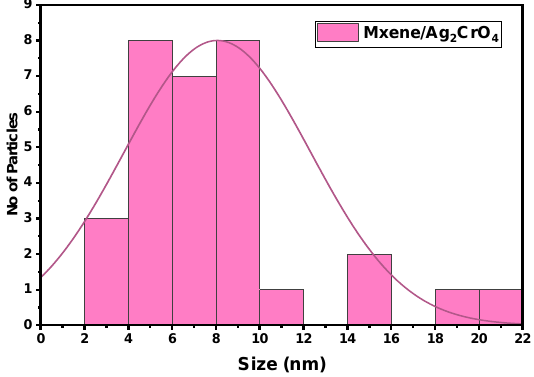
Figure 3. Particle size distribution histogram determined by SEM images.